Question: What style of plot is this figure drawn as?
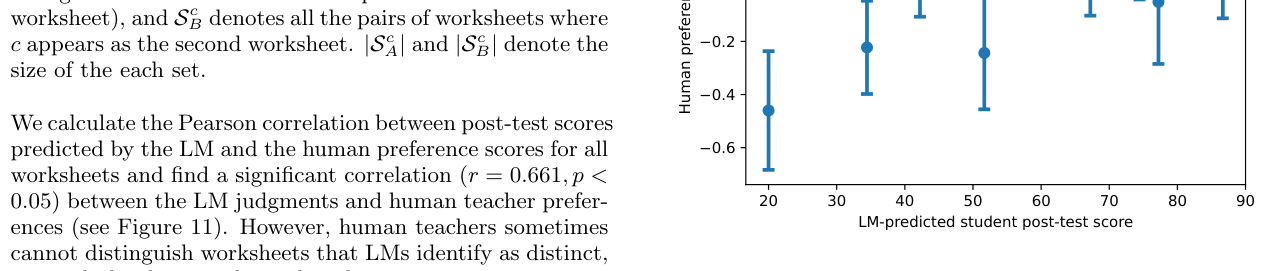
Answer: bar